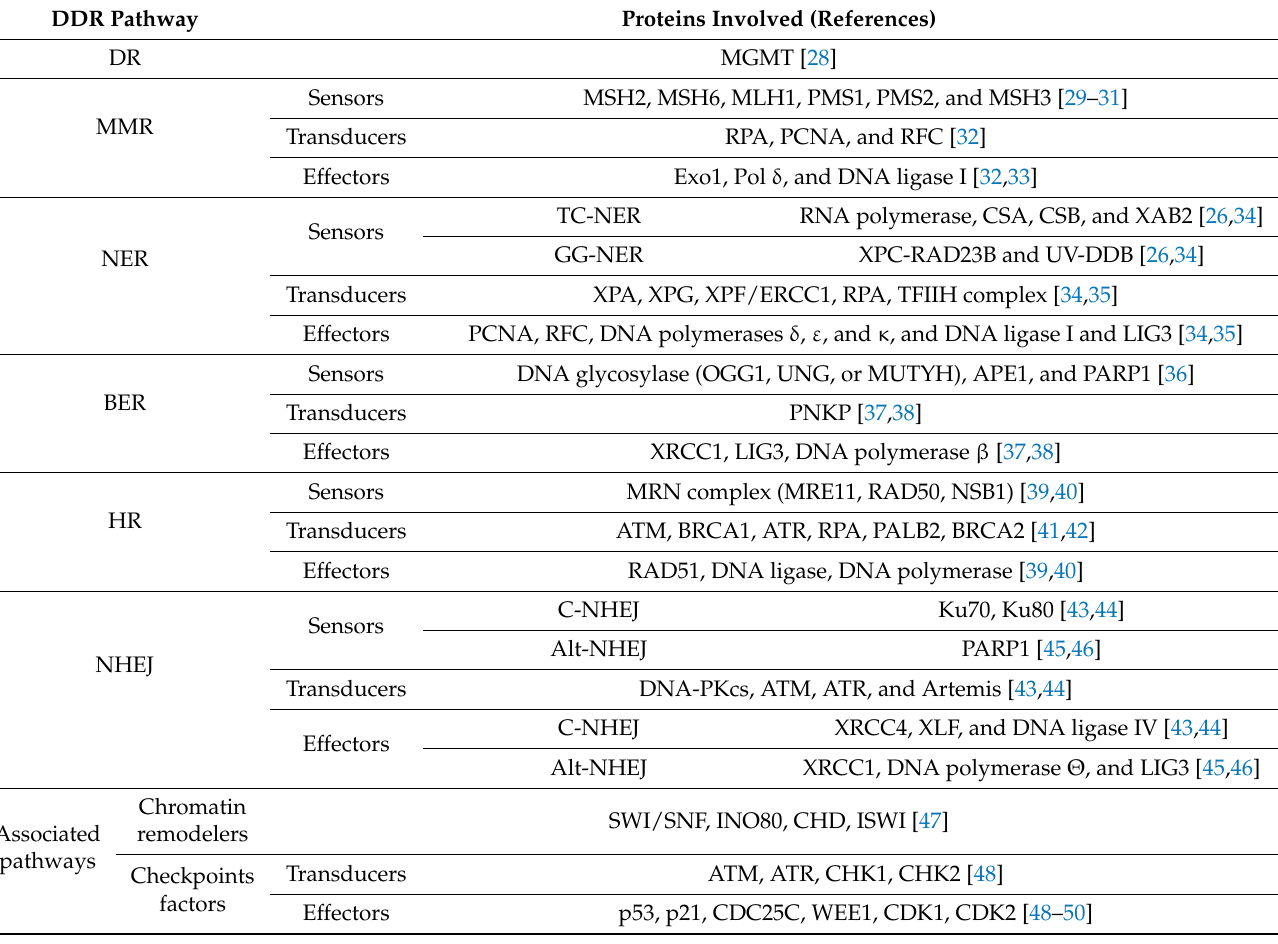
Table 2. Main proteins involved in each DDR